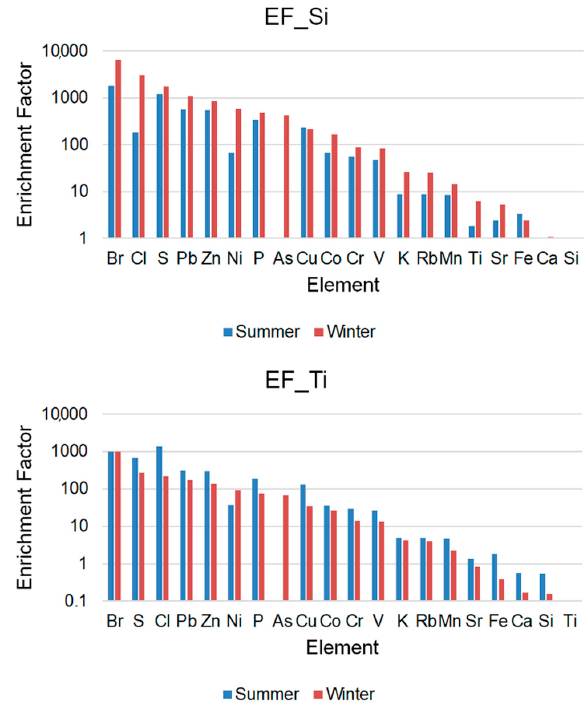
Figure 3. Enrichment factors (EFs) for the analyzed elements, with Si and Ti as reference elements.